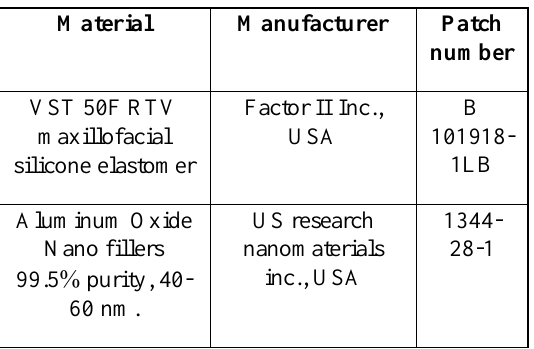
Table 1: The study